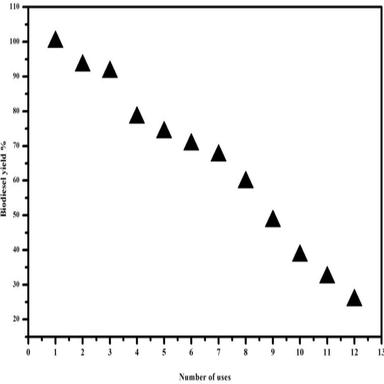
Reusability of hybrid BSC for relative percentage yield of biodiesel at constant reaction parameters: 50 ± 1 C 24 h, 6:1 alcohol to crude Castor oil ratio and10% hybrid BSC on oil amount.